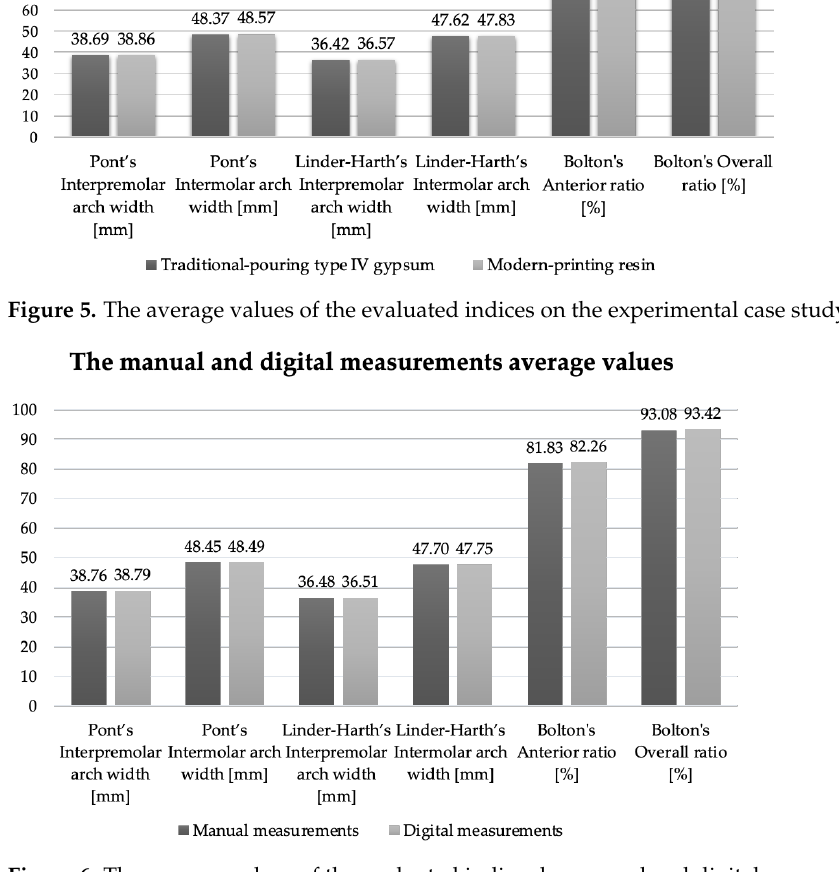
Figure 6. The average values of the evaluated indices by manual and digital measurements. Table 4 shows statistically significant values for the measured indices: Pont inter- premolar and intermolar arch widths ( p < 0.05) and Linder–Harth interpremolar and intermolar arch widths ( p < 0.05) at the level of printed models versus traditional ones. When the difference between the calculated and the measured values was evaluated, a statis- tically insignificant result ( p = 0.83—Pont’s and Linder–Harth’s interpremolar arch widths; p = 0.59—Pont’s and Linder–Harth’s intermolar arch widths) was